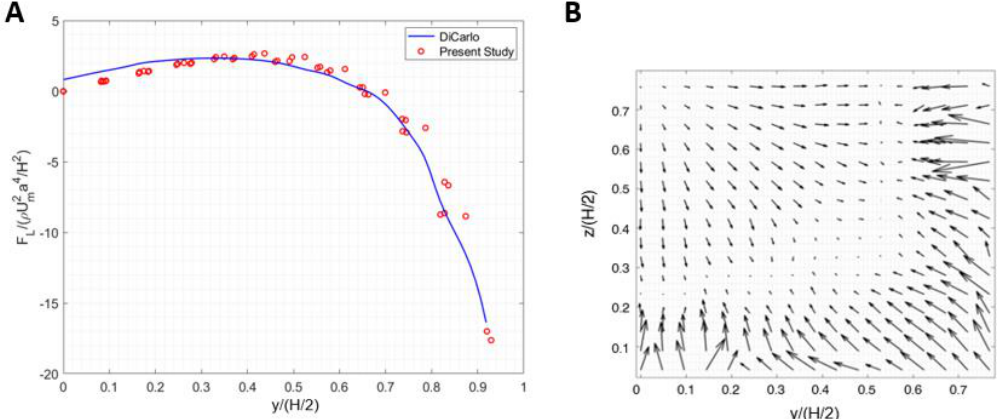
Figure 5. ( A ) Calculated inertial force in a straight channel at z = 0 using the algorithm in the present study versus inertial force reported by Ref. [31]. ( B ) Calculated inertial force field acting on a 10 µm particle in the present study.